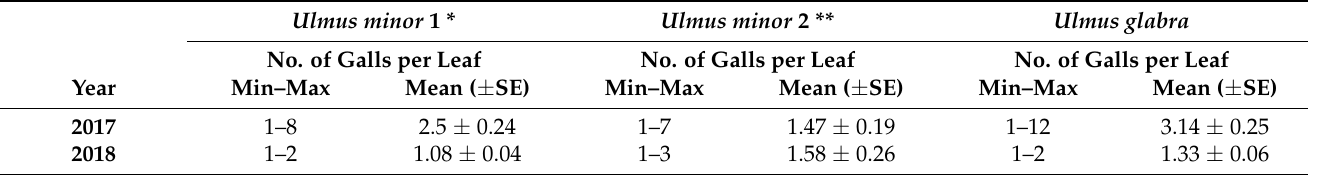
Table 3. Number of T. nigriabdominalis galls on U. minor and U. glabra (mean ± SE (standard error)). Ulmus minor 1